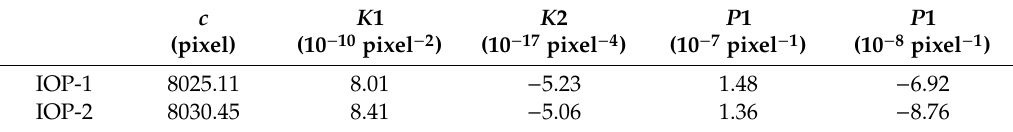
Table 9. Two sets of camera parameters for evaluating the impact of initial values on refined IOPs.